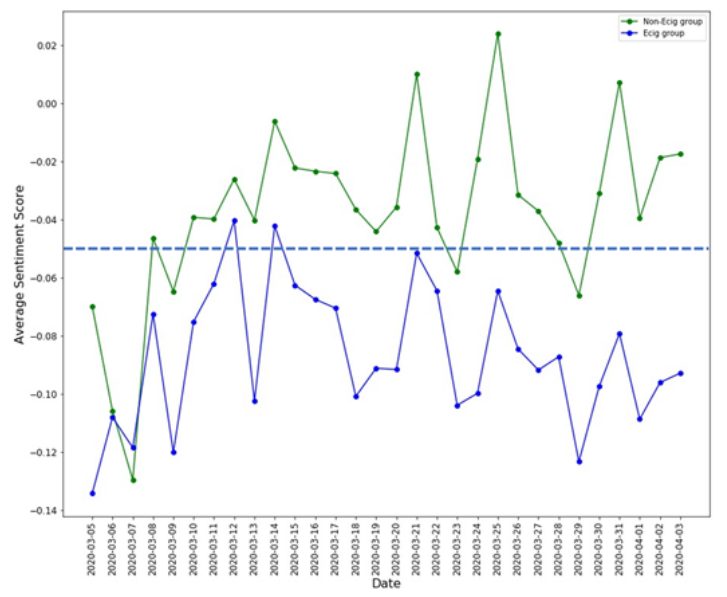
Figure 1. Comparison of different sentiments toward COVID-19 between US-based Twitter users who used e-cigarettes (Ecig group) and those who did not use e-cigarettes (non-Ecig group) from March 5, 2020, to April 3,